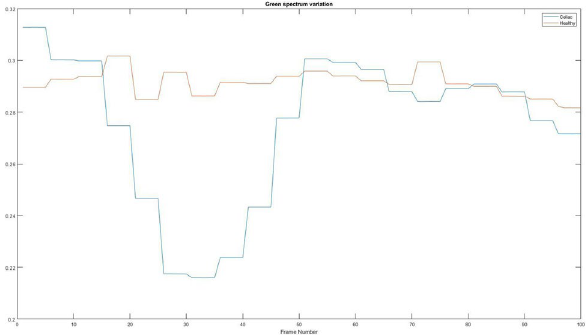
Figure 15. Green spectrum variation. Red = Healthy and Blue = Celiac.